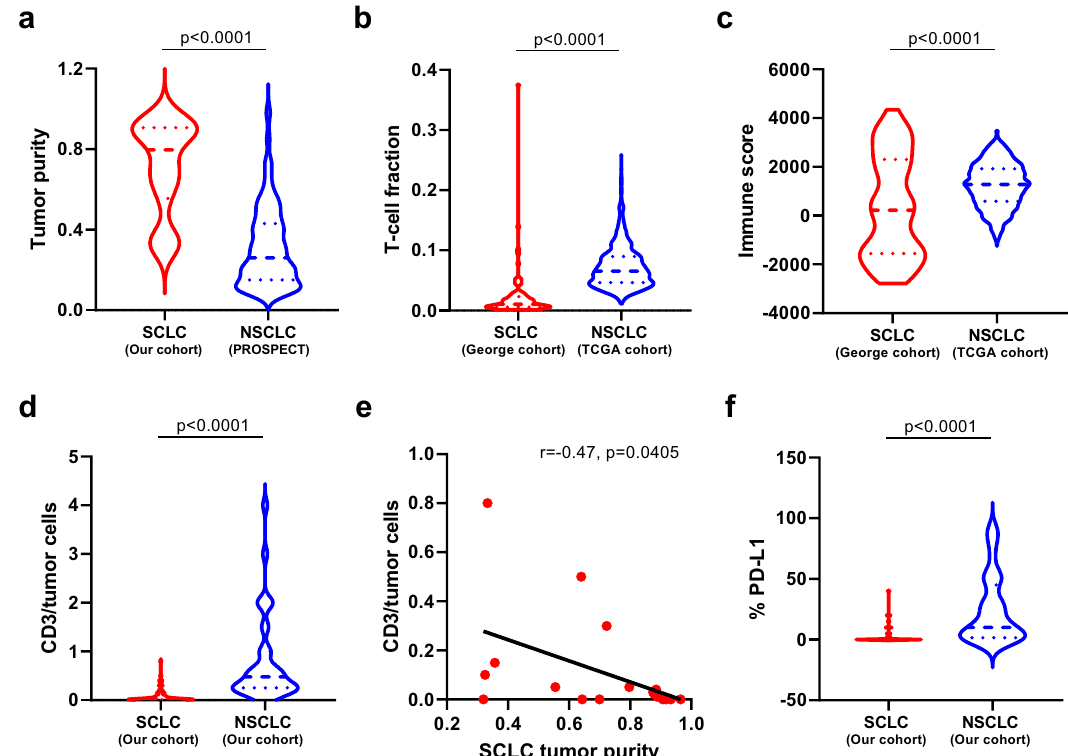
Fig. 3 Comparison of immune features in small-cell lung cancer (SCLC) versus non-small cell lung cancer (NSCLC). a Tumor purity in SCLCs versus NSCLCs. Tumor purity was derived from whole-exome sequencing (WES) data from 19 SCLC tumors (blue) versus 242 NSCLC tumors (red) from the PROSPECT cohort. b T-cell in fi ltration in SCLCs compared with NSCLCs. T-cell in fi ltration was derived by deconvolution of RNA sequencing (RNA-seq) data of 81 SCLC tumors (George cohort) versus 1027 NSCLC tumors from TCGA. c Immune score in SCLCs compared with NSCLCs. The immune score was calculated from RNA-seq data to quantify all immune cells within the tumors from 81 SCLC tumors (George cohort) versus 1027 NSCLC tumors from TCGA. d CD3 + tumor-in fi ltrating lymphocytes (TILs) of SCLC ( n = 67) versus NSCLC ( n = 68) tumors by immunohistochemistry (IHC). The y axis represents CD3 + TILs: tumor-cell ratio. e Association of tumor purity with CD3 + TILs in SCLCs ( n = 19). The y axis represents CD3 + TILs: tumor-cell ratio. f Expression of programmed death ligand-1 (PD-L1) by IHC in SCLC ( n = 67) versus NSCLC ( n = 68) tumors. The difference of immune features between SCLC and NSCLC was evaluated using two-sided Mann – Whitney test. The correlation coef fi cient (r) of tumor purity with CD3 + TILs was assessed by two-tailed Spearman ’ s rank-correlation test. Source data are provided as a Source Data fi le.